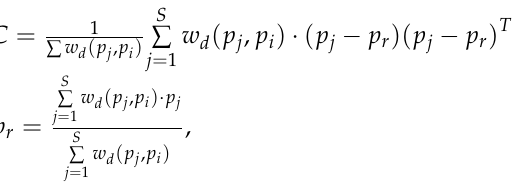
 . Figure 3 indicates that our method can still perform accurate feature detection even if un- der large-scale noise. Note that in practical implementation, there is no strict standard for the selection of both, which depends on the prior cognition of the processing object.